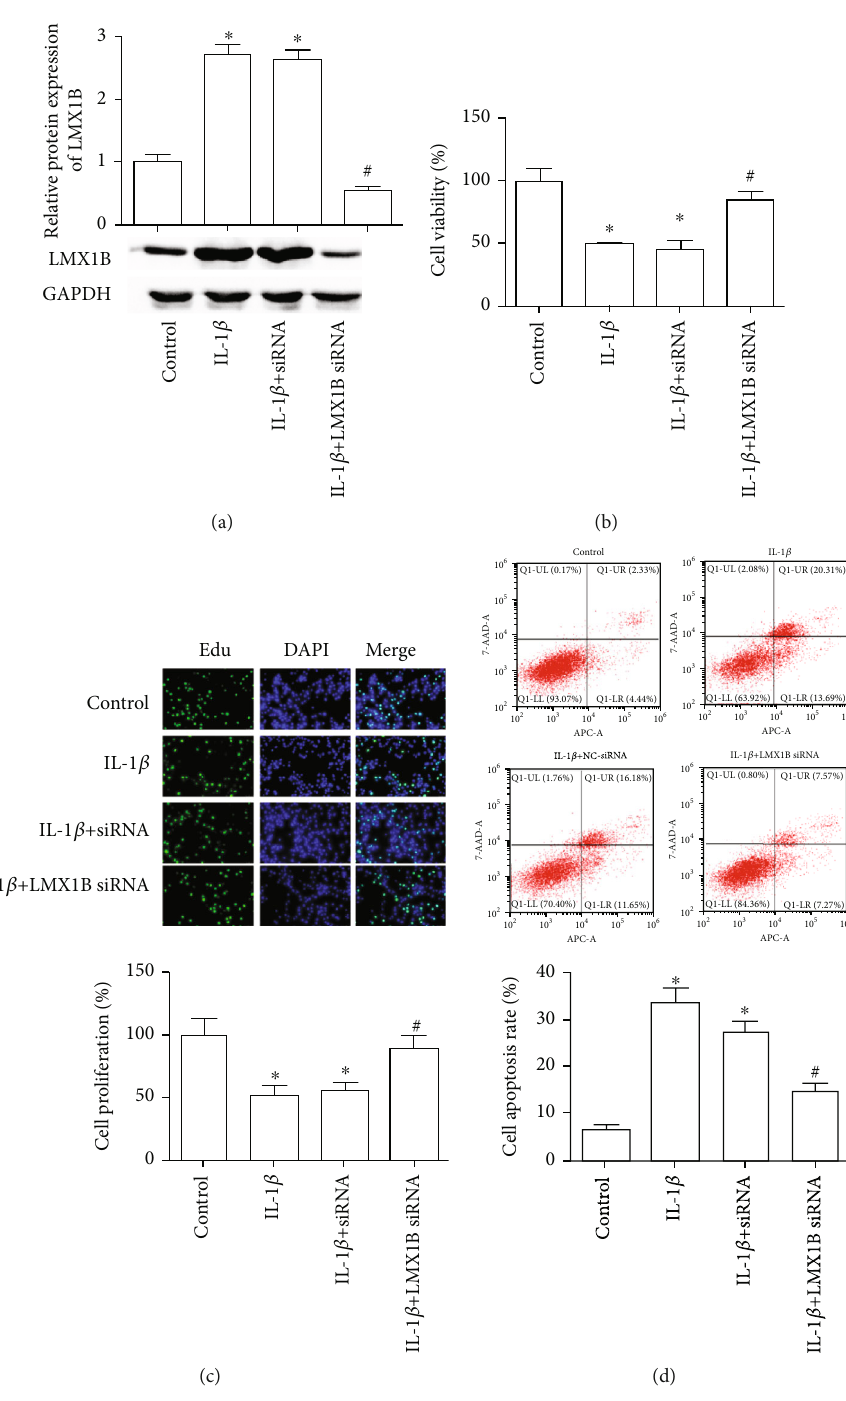
Figure 2: LMX1B knockdown increased IL-1 β -induced SW1353 cell growth and suppressed its apoptosis. (a) Western blot analysis for LMX1B protein expression; (b) CCK-8 analysis for SW1353 cell survival; (c) 5-ethynyl-2 ′ -deoxyuridine (EdU) assay was used to determine SW1353 cell proliferation; (d) SW1353 cell apoptosis was detected by using fl ow cytometer analysis. SW1353 cells were transfected with control siRNA or LMX1B siRNA for 24h by using Lipofectamine 2000 reagent and then treated with 10ng/ml IL-1 β for 24h. ∗ P < 0 : 05 , compared with the control group; # P < 0 : 05 , compared with the IL-1 β group. All experiments were repeated three (ab263899, 1:1000) rabbit monoclonal to p-P65 (ab76302, 1:1000), rabbit monoclonal to NF- κ B p65 (ab32536, 1:5000), and rabbit polyclonal to GAPDH (ab9485, 1:2500).